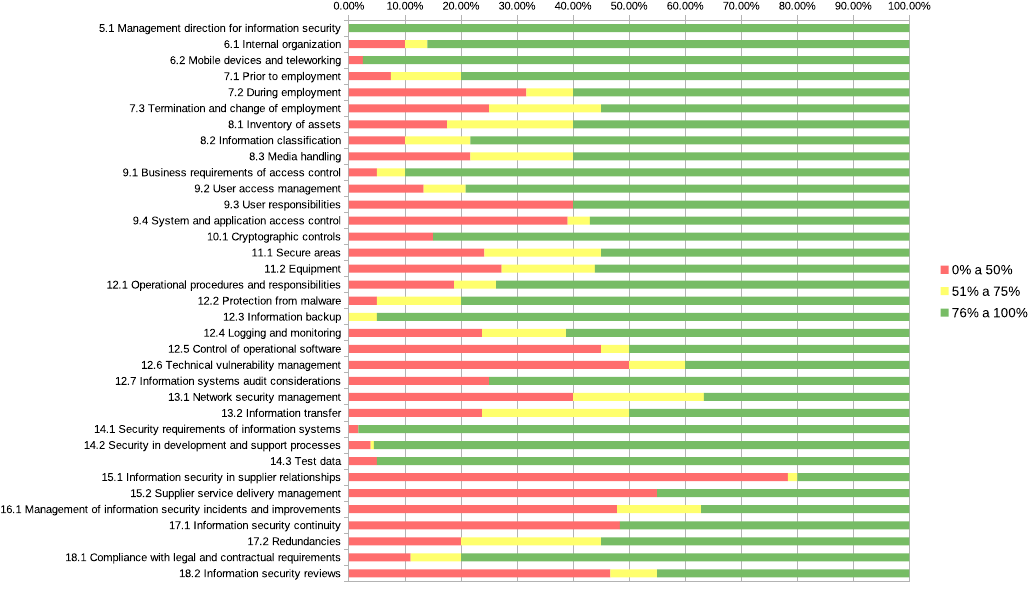
Figure 7. Type 2—Cumulative Acceptance Percentage of ISO-27001:2013 standard sections, by intervals—Second